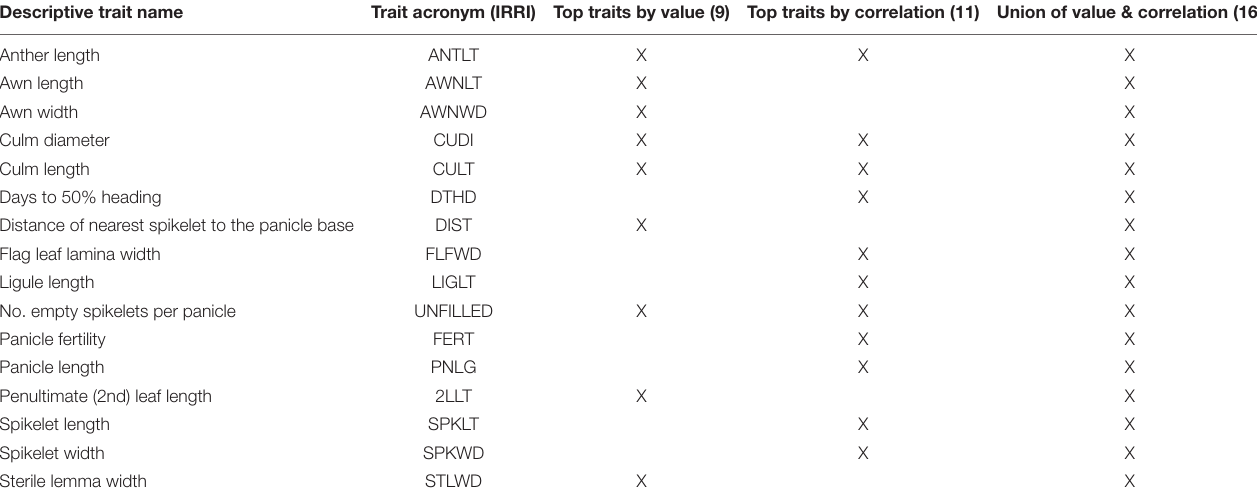
TABLE 1 | Phenotypic traits identified by trait value (9 traits), correlation switching (11 traits) and the union of both sets of traits (16 traits) based on the analysis of the phenotypic trait data collected at IRRI. Descriptive trait